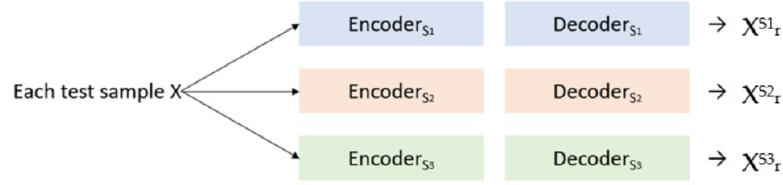
Figure 5. Reconstruct the test image X with three autoencoders separately.